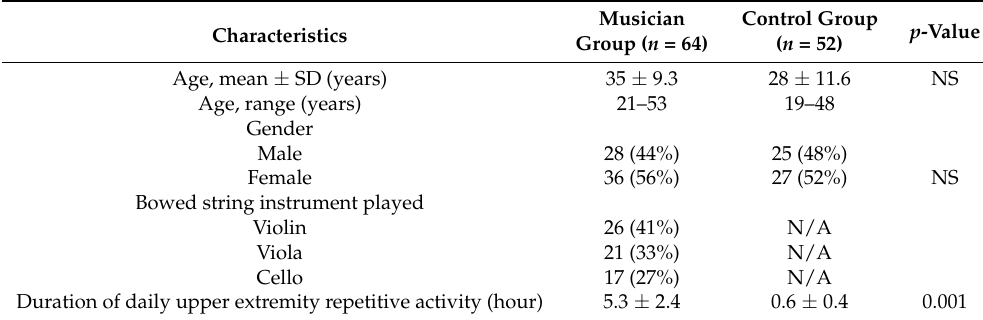
Table 1. Baseline demographic information and upper extremity